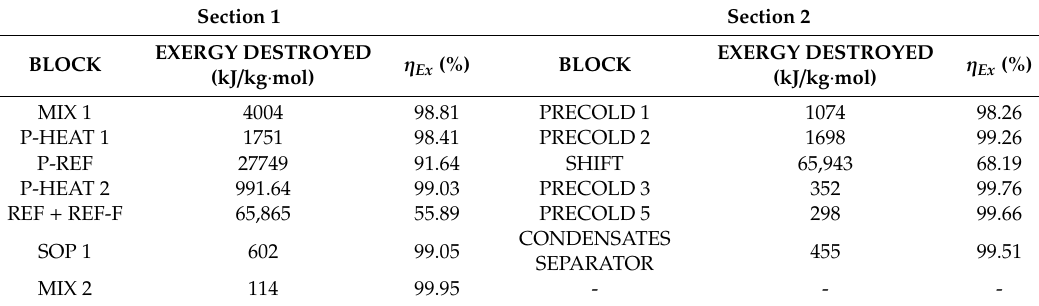
Table 7. Exergetic analysis of Section 1 and Section